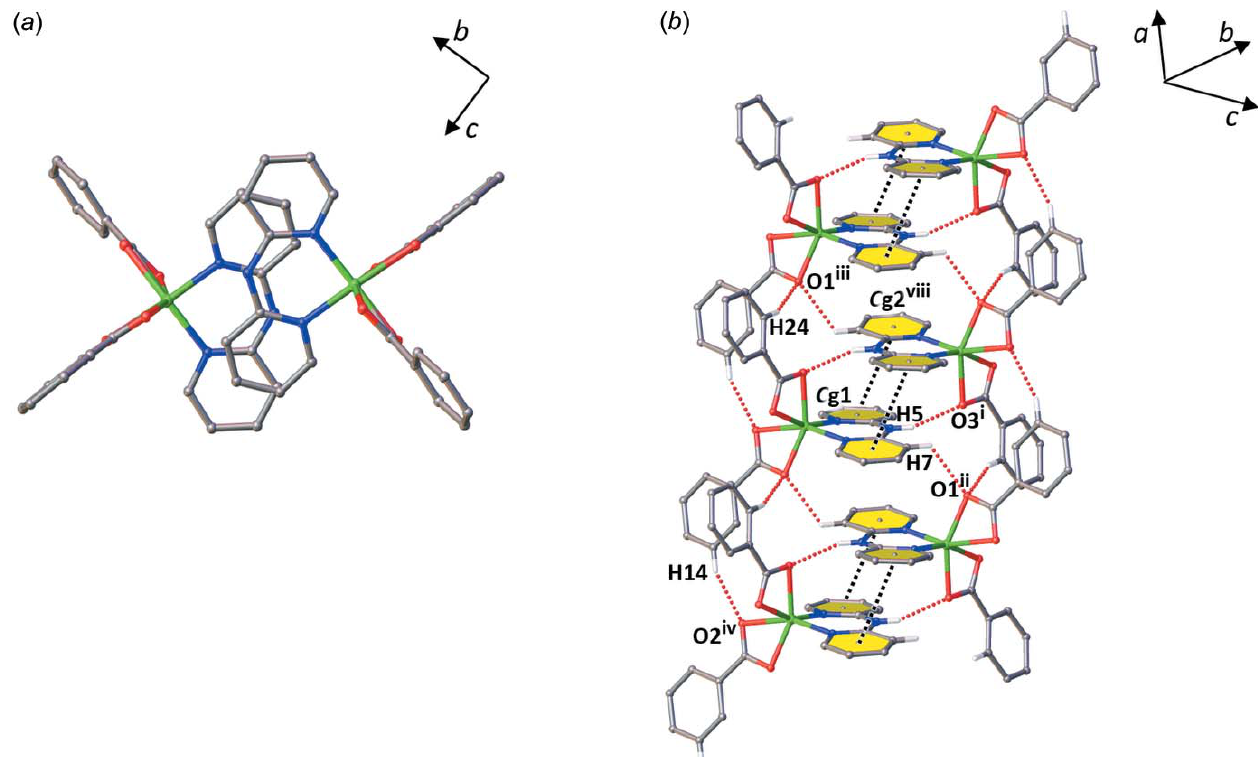
Figure 2 Views of lattice arrangement of the title complex along the [100] direction, ( a ) top view and ( b ) the weak intermolecular interactions, N—H (cid:2)(cid:2)(cid:2) O, C— H (cid:2)(cid:2)(cid:2) O and (cid:2) – (cid:2) , between dimeric units, showing the one-dimensional supramolecular chain-like